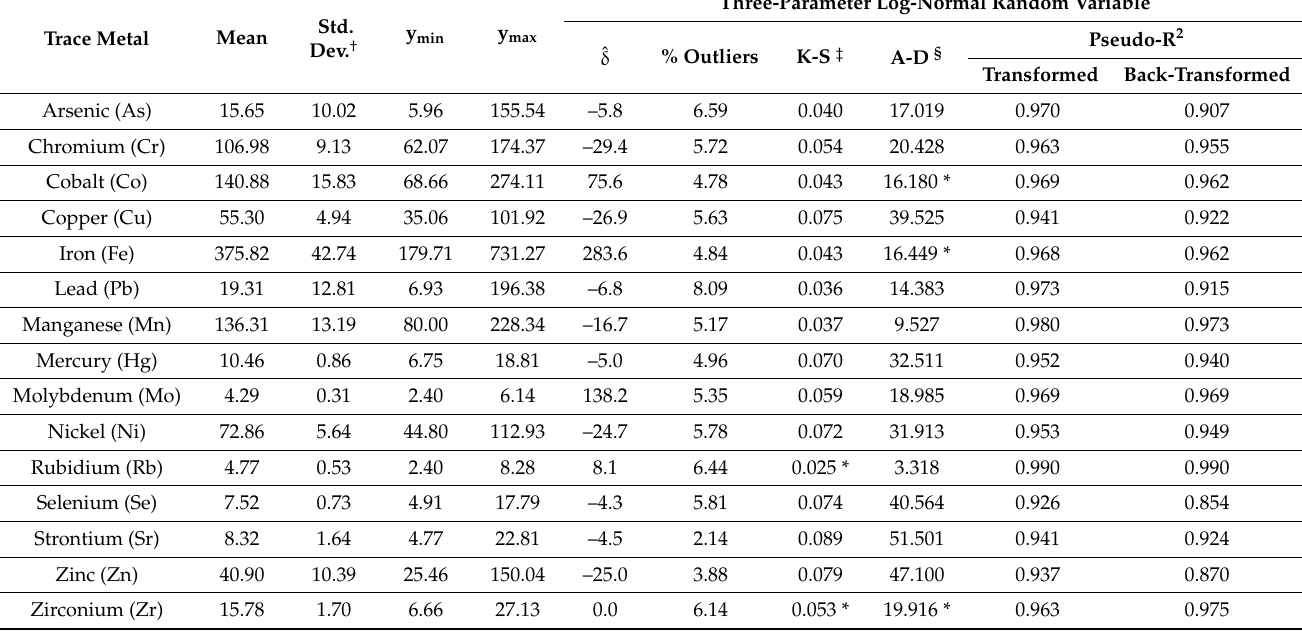
Table 2. Selected descriptive statistics for the theoretical analytical error of the 15 trace metals measured via Syracuse soil sample assaying ( n = 3324 soil sample